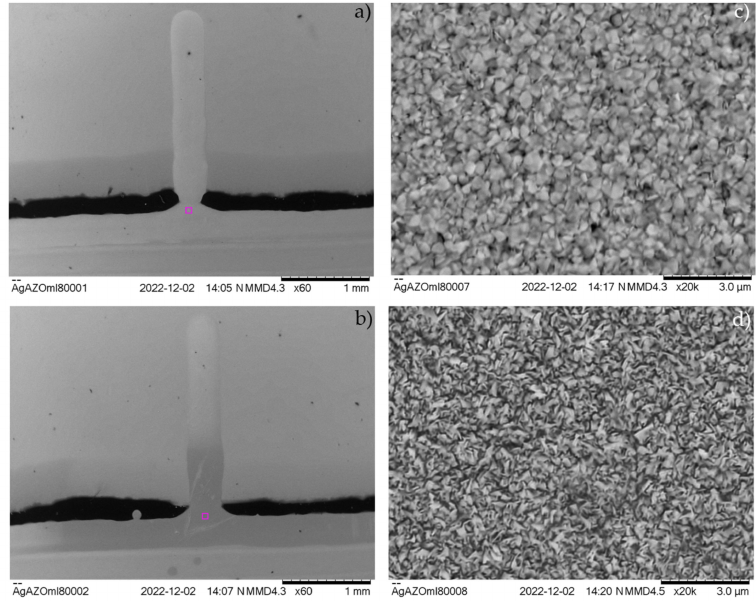
Figure 14. 15 kV secondary electron SEM image of a silver contact before and after the exposure to atomic oxygen: ( a ) overview of silver contact before; ( b ) overview of silver contact after atomic oxygen exposure; violet square shows the region of the picture sections for ( c ) the non-degraded silver crystal grains; and ( d ) the degraded silver crystal